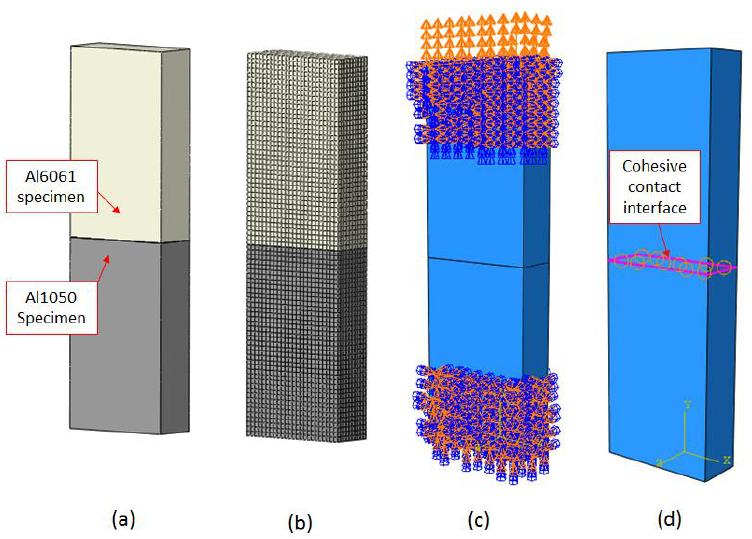
Figure 8. Computational model of the tensile tests: ( a ) Model geometry; ( b ) Representative mesh; ( c ) Boundary conditions; ( d ) cohesive contact interface for modelling bonded region.